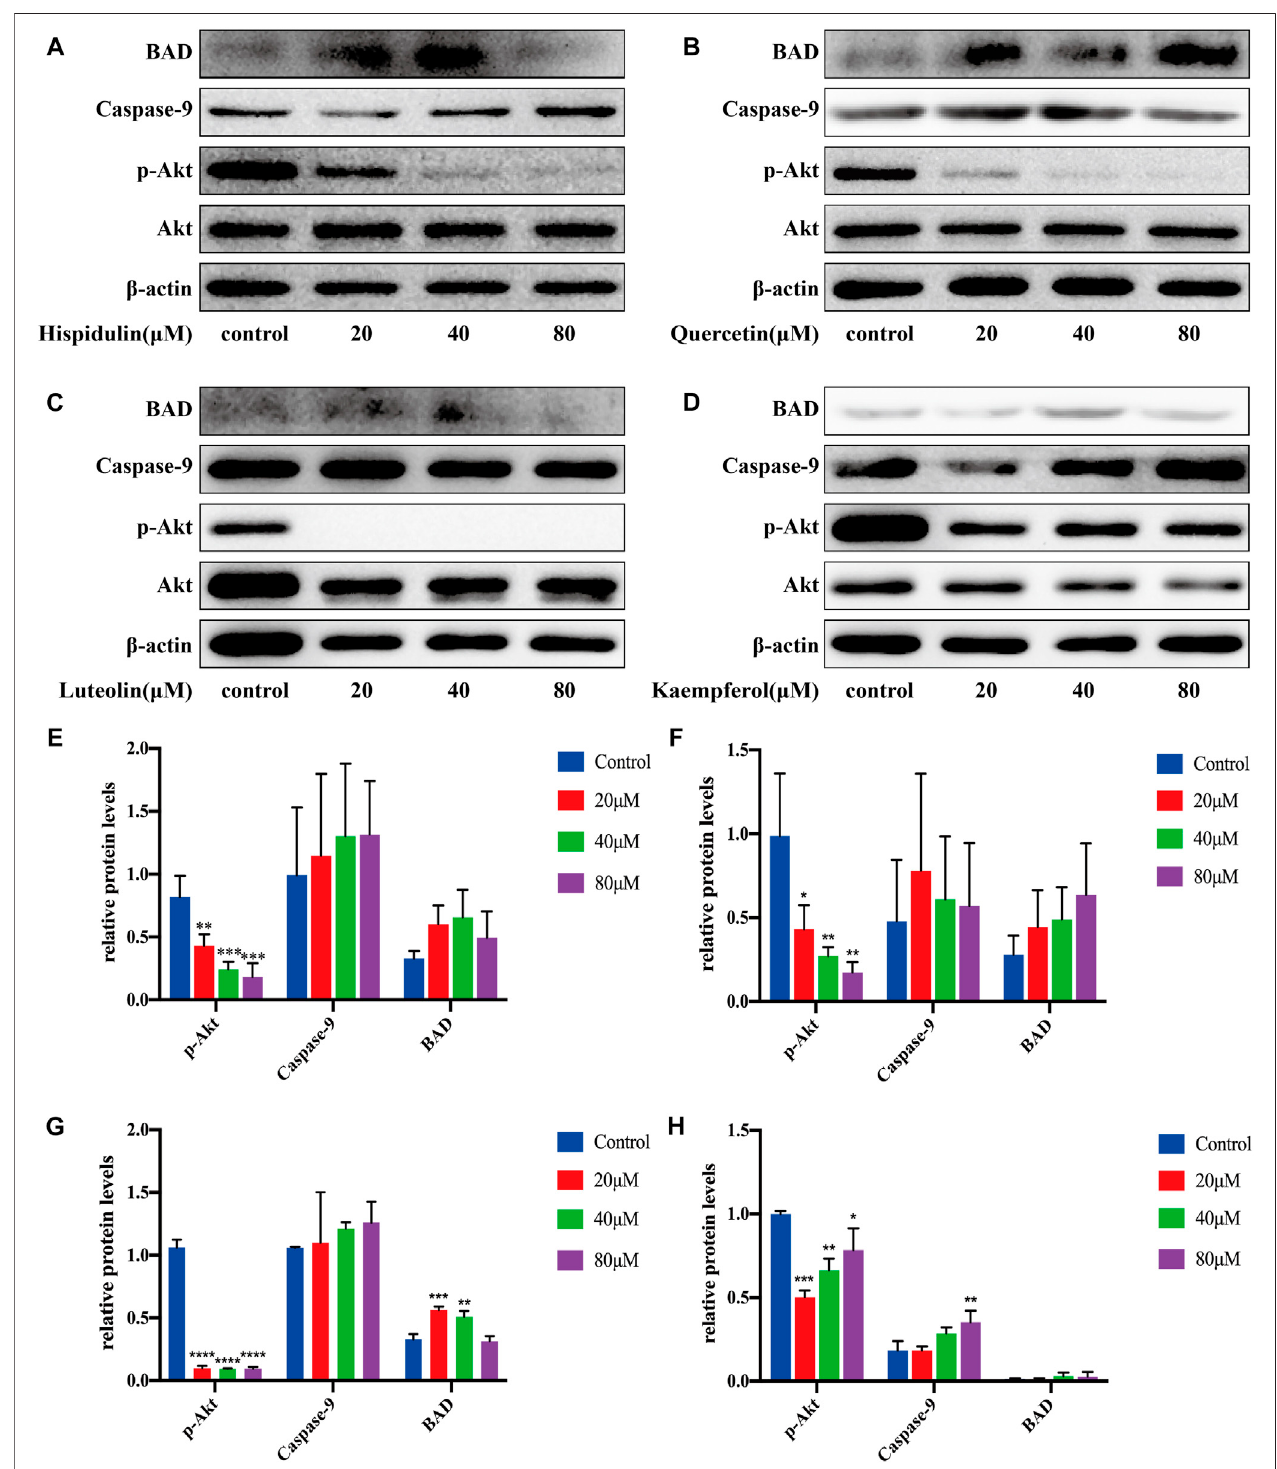
FIGURE10| WesternblotanalysisofAkt,p-Akt,caspase-9,andBADexpressionsinC6cells. (A) Cellsweretreatedwithorwithouthispidulin(0,20,40,or80 μ M) for 24 h. (B) Cells were treated with or without quercetin (0, 20, 40, or 80 μ M) for 24 h. (C) Cells were treated with or without luteolin (0, 20, 40, or 80 μ M) for 24 h. (D) Cells were treated with or without kaempferol (0, 20, 40, or 80 μ M) for 24 h. (E) Quanti fi cation data of western blot in group A. (F) Quanti fi cation data of western blot in groupB. (G) Quanti fi cationdataofwesternblotingroupC. (H) Quanti fi cationdataofwesternblotingroupD.Experimental valuesareexpressed asmean ± SDfor each group ( n (cid:2) 3, * p < 0.05, ** p < 0.01, *** p < 0.001, and **** p < 0.0001 with the control group).